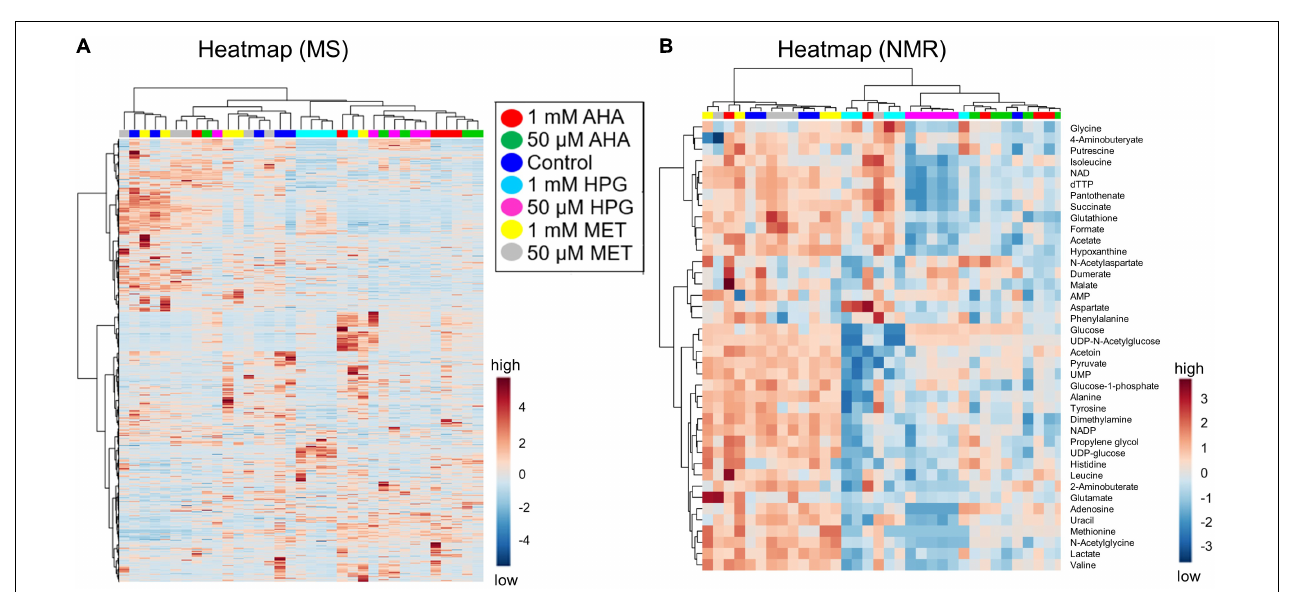
FIGURE 2 | Heatmaps of treatment groups clustered on metabolite intensity from E. coli NCAA experiment. (A) MS data and (B) NMR data are shown. The scale of the heat map indicates blue as lowest and red as highest in abundance as calculated across sample groups after normalization using fold change. (A) The heatmap with HCA of 4,036 features as detected by MS is shown. The lack of clustering of the different experimental groups and no significant patterns of up- or down-regulated features for the different groups are indicative of a lack of differentiation between sample types. (B) The NMR data (40 metabolites) also shows a lack of group clustering, the only exception being the group with 50 µ M HPG. For enlarged images with metabolite names and sample identifications see Supplementary Figure S5 .